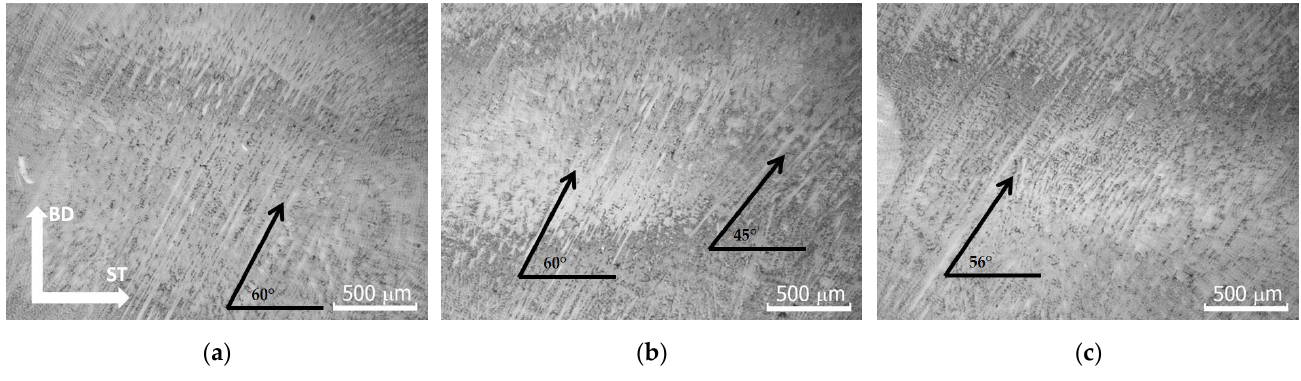
Figure 6. Material structure in initial ( a ), transitional ( b ) and repaired ( c ) areas. The black arrows show the angle of growth of the dendritic axes relative to the scanning trajectory. BD — building direction, ST — scanning